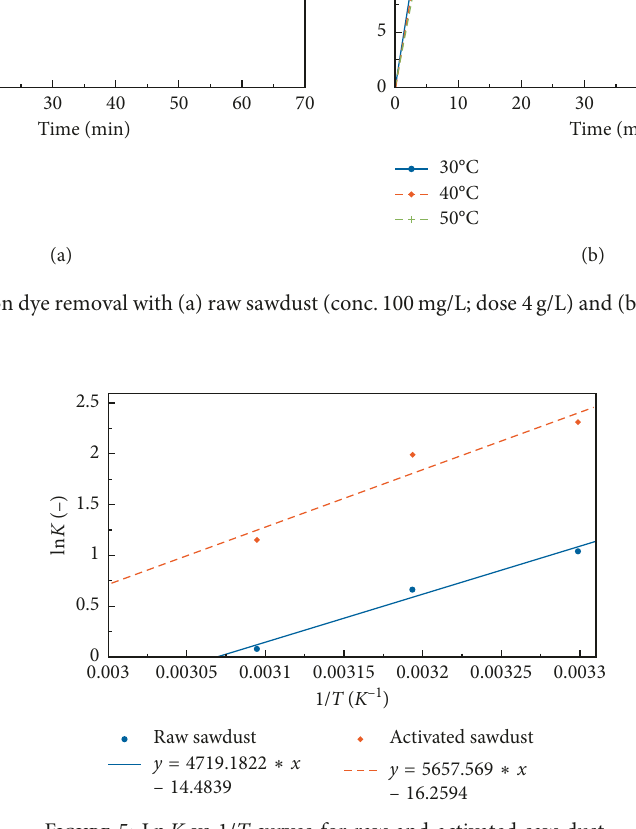
Figure 5: Ln K vs 1/ T curves for raw and activated saw dust. Table 1: Thermodynamic parameters at different